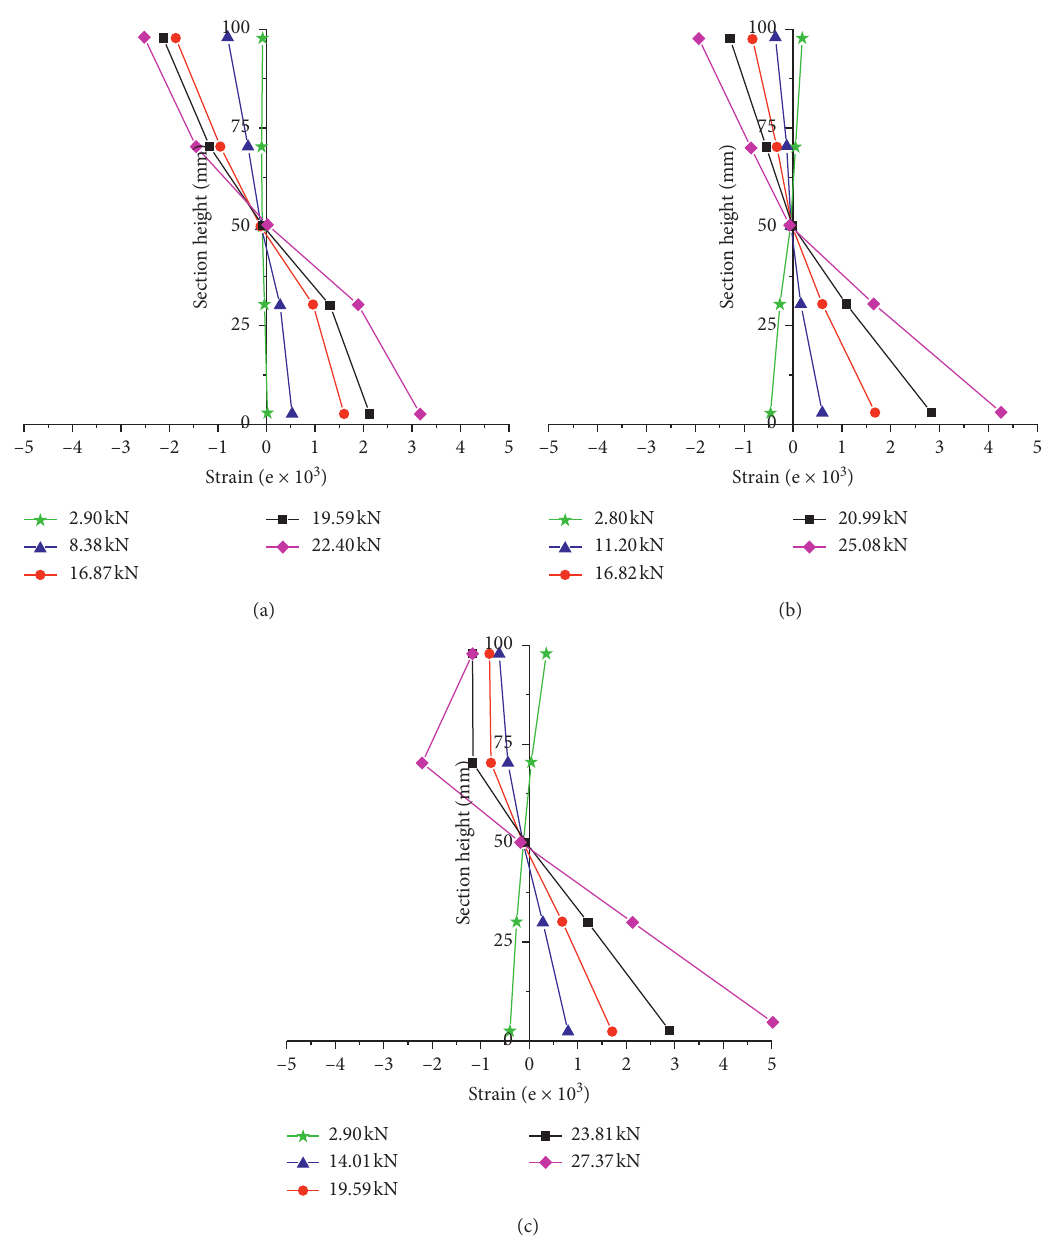
Figure 12: Section-strain curve of test beams in group A. (a) SPF-1.1. (b) SPF-1.2. (c)